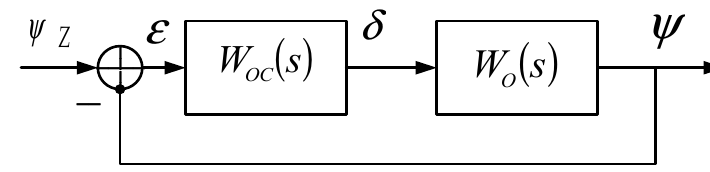
Figure 6. “Rigid” vehicle course stabilization contour.